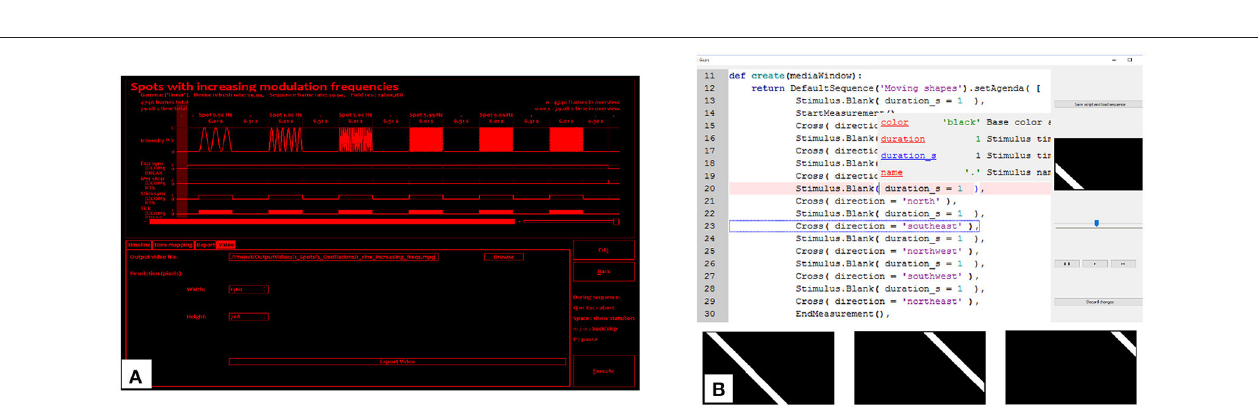
FIGURE 1 | The GEARS software stack. Stimulus sequences can be executed using the GEARS GUI. New sequences can be composed with a built-in visually aided script editor. A library of ready-to-use, parametrizable stimuli and stimulus sequence scripts are provided. Custom stimuli can be assembled from stimulus building components.